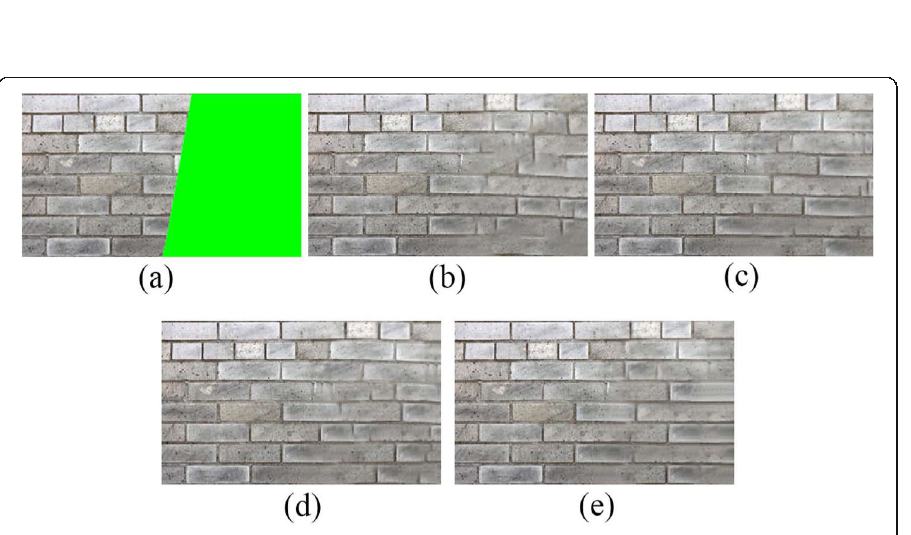
Fig. 13 Effect of gradient and consistency. a Input. b Unguided completion. c Gradient guide only. d Consistency guide only. e Gradient and consistency